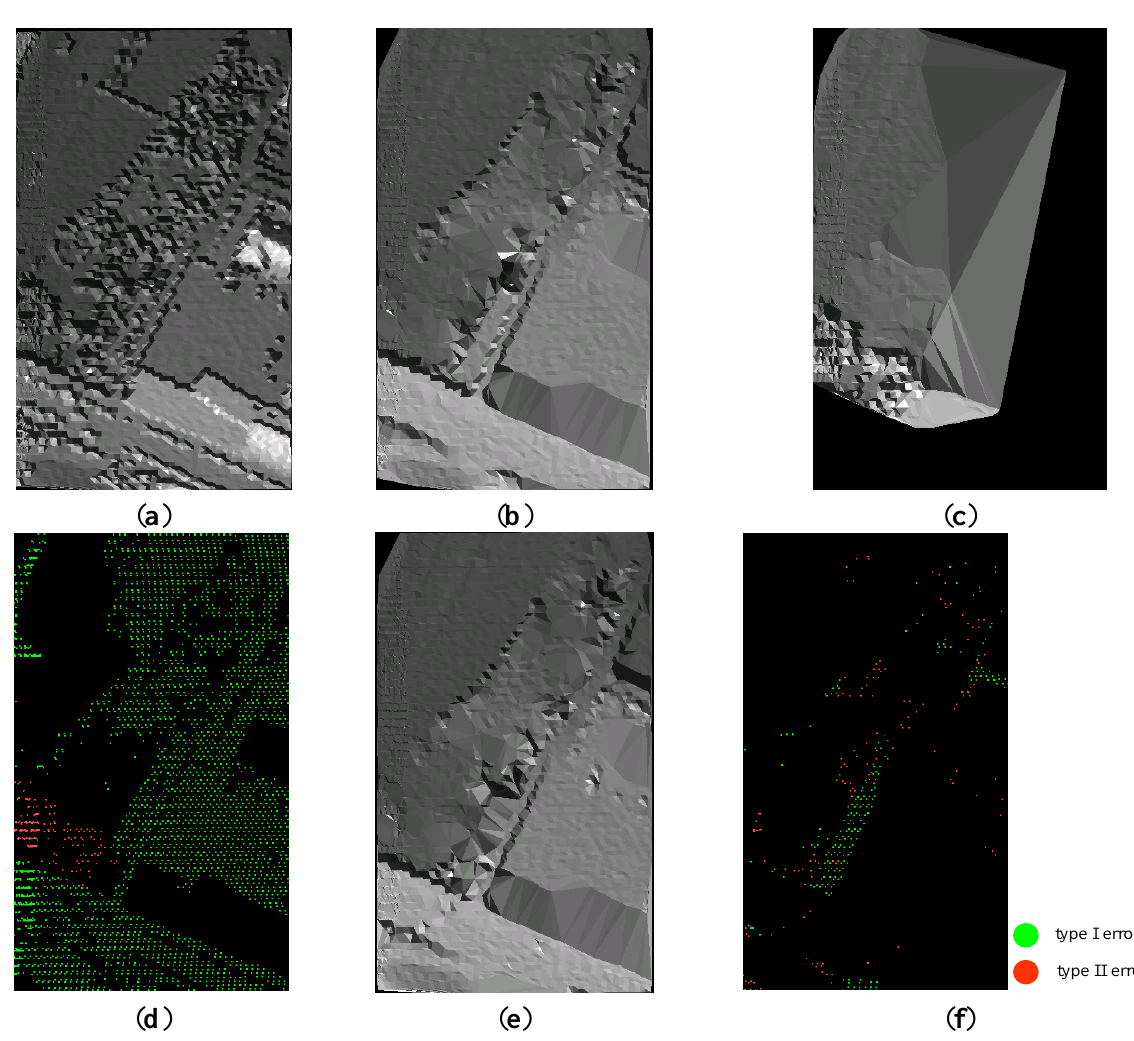
Figure 8. Filtering and results of reference data of Sample 24: ( a ) The DSM; ( b ) The reference DEM; ( c ) The DEM generated from the result of the PTD method; ( d ) The type I errors, type II errors of the PTD method; ( e ) The DEM generated from the result of the SBF method; ( f ) The type I errors, type II errors of the SBF method. Note that both of the DSM and the DEM are